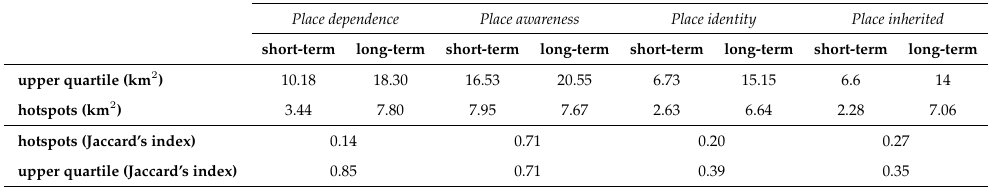
Place awareness Place identity Place inherited